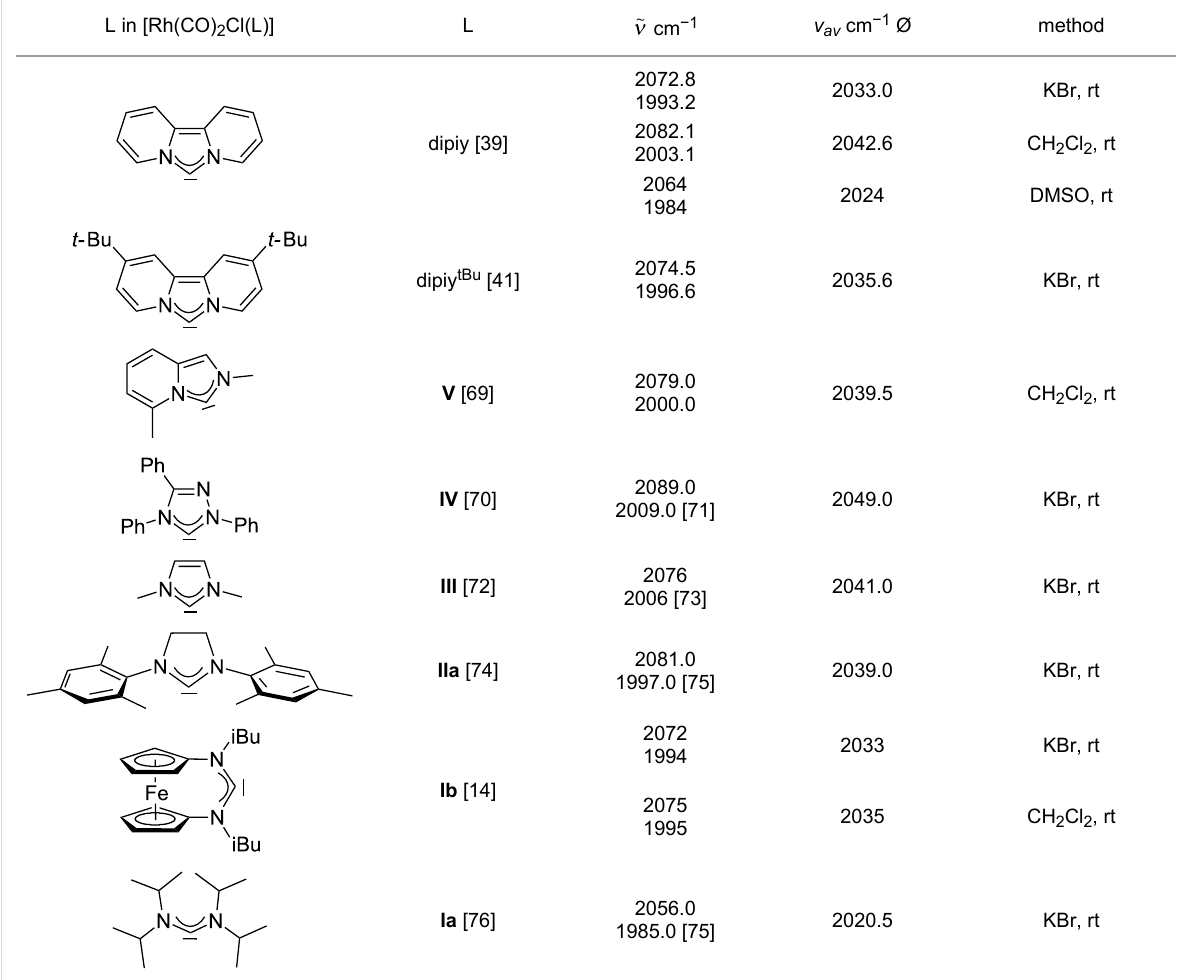
Table 1: IR carbonyl stretching frequencies of [Rh(CO) 2 Cl(L)] complexes bearing various diaminocarbenes (L). L in [Rh(CO) 2